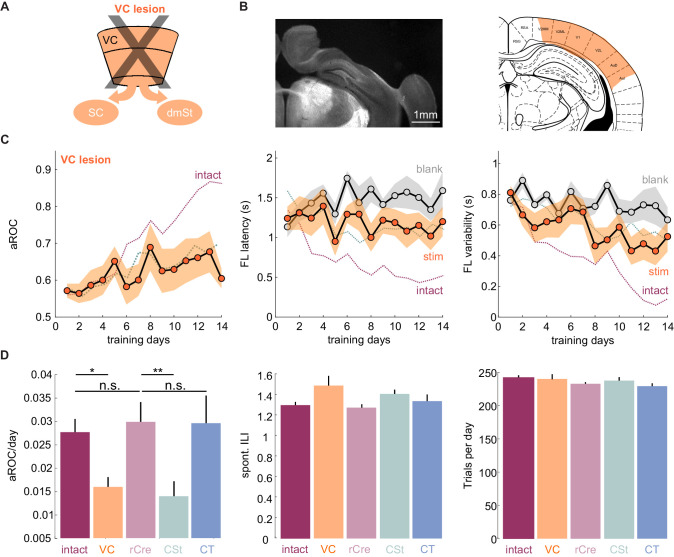
VC lesions recapitulate learning impairment induced by the ablation of cortico-striatal neurons.(A) Schematic of surgical ablation of visual cortex (VC). (B) Left: Coronal sections from an example mouse illustrating the surgical ablation of the right VC. Right: Corresponding coronal plane from the Paxinos mouse brain atlas with the spread of the lesion in orange shading. (C) Population average learning curves over 14 days of training for mice in which VC was surgically ablated before the onset of training (N = 8 mice). The purple dotted line is data from intact animals (from Figure 1C) for comparison. Green dotted line is data from CSt-ablated animals (from Figure 1E) for comparison. Data plotted as mean ± SEM. Note that the VC lesion recapitulates the learning impairment of CSt-ablated mice. (D) Left: Population average slope aROC/day across experimental groups. Intact (gray), VC lesion (VC: orange), retroAAV-Cre only (rCre: purple), CSt-lesion (CSt:aqua), CT-lesion (CT: blue). Middle: Population average of spontaneous licking (ILI: inter lick time interval) behavior during the gray screen period of the inter trial interval (ITI). Right: Population average number of trials per training session. Data plotted as mean ± SEM.Figure 2—source data 1.Behavioral performance measurements as a function of training days during task acquisition for VC-lesioned animals and comparison of behavioral metrics across experimental groups.